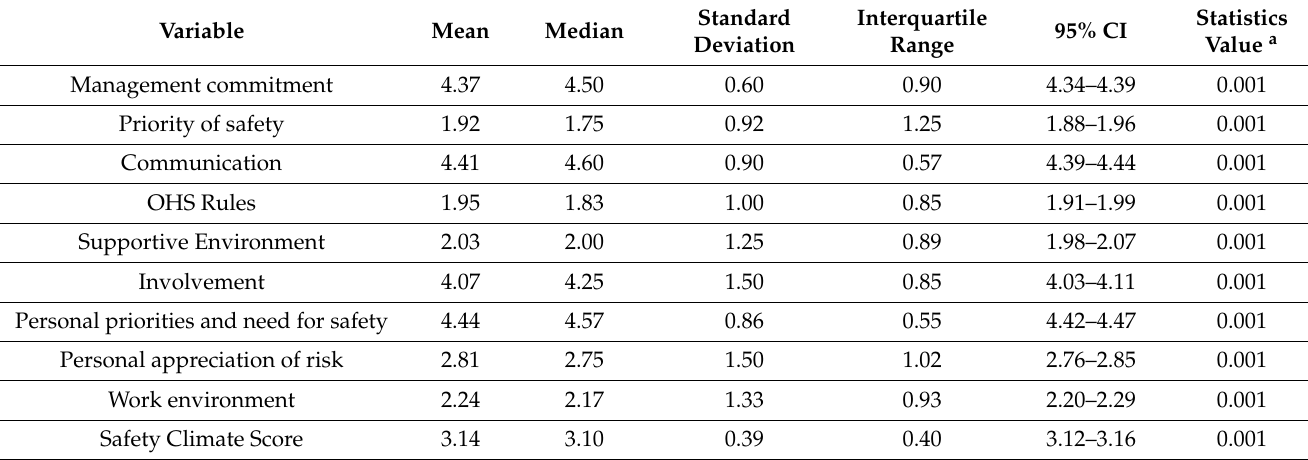
Table 4. Description of elements of the safety climate and test of normality.